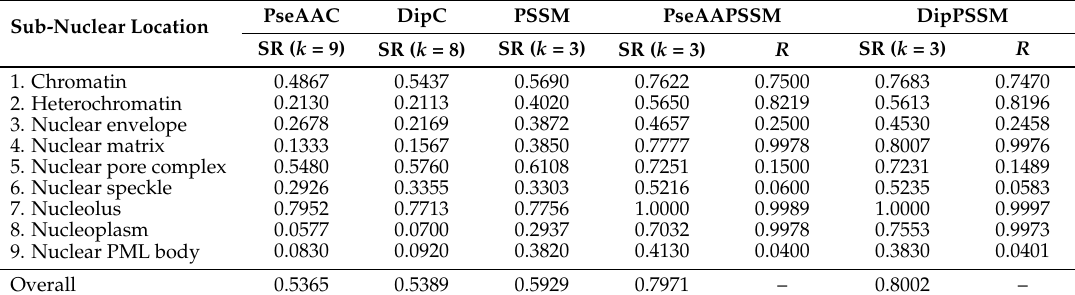
Table 4. Prediction success rate (SR) and the optimal R of Dataset 1 for protein sub-nuclear localization by 10-fold cross validation with various representations.